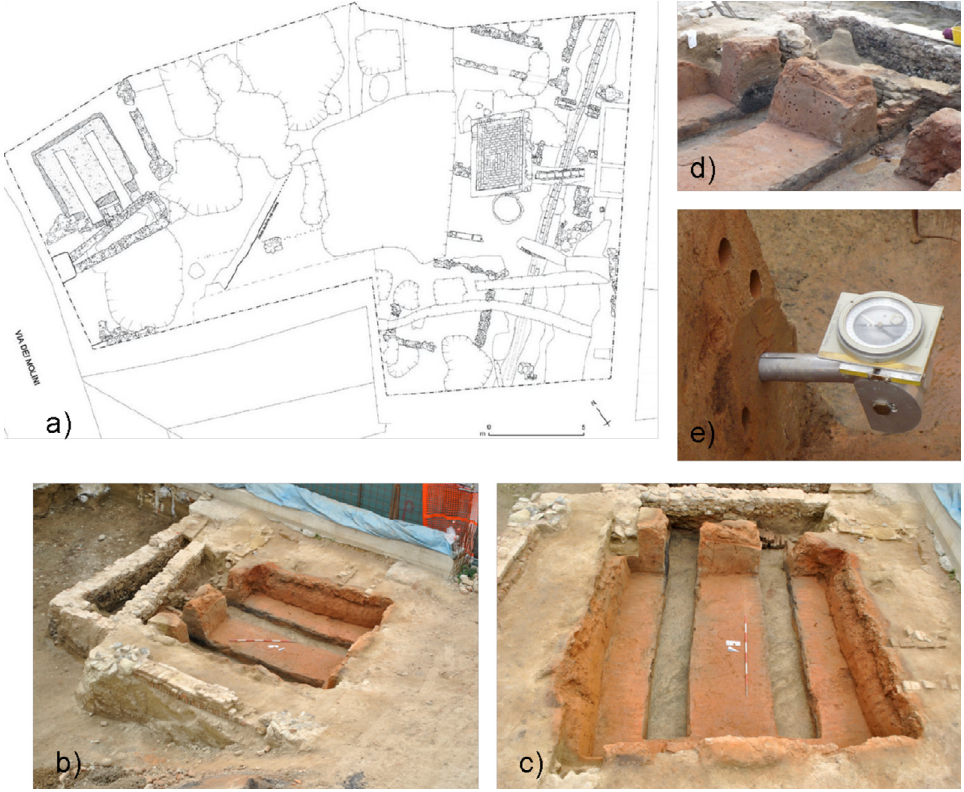
Figure 1. (a) General planimetry of the archaeological site excavated in via dei Molini, Chieri; (b-d) photos of the studied kiln; (e) in situ ori- entation of the collected samples for archaeomagnetic